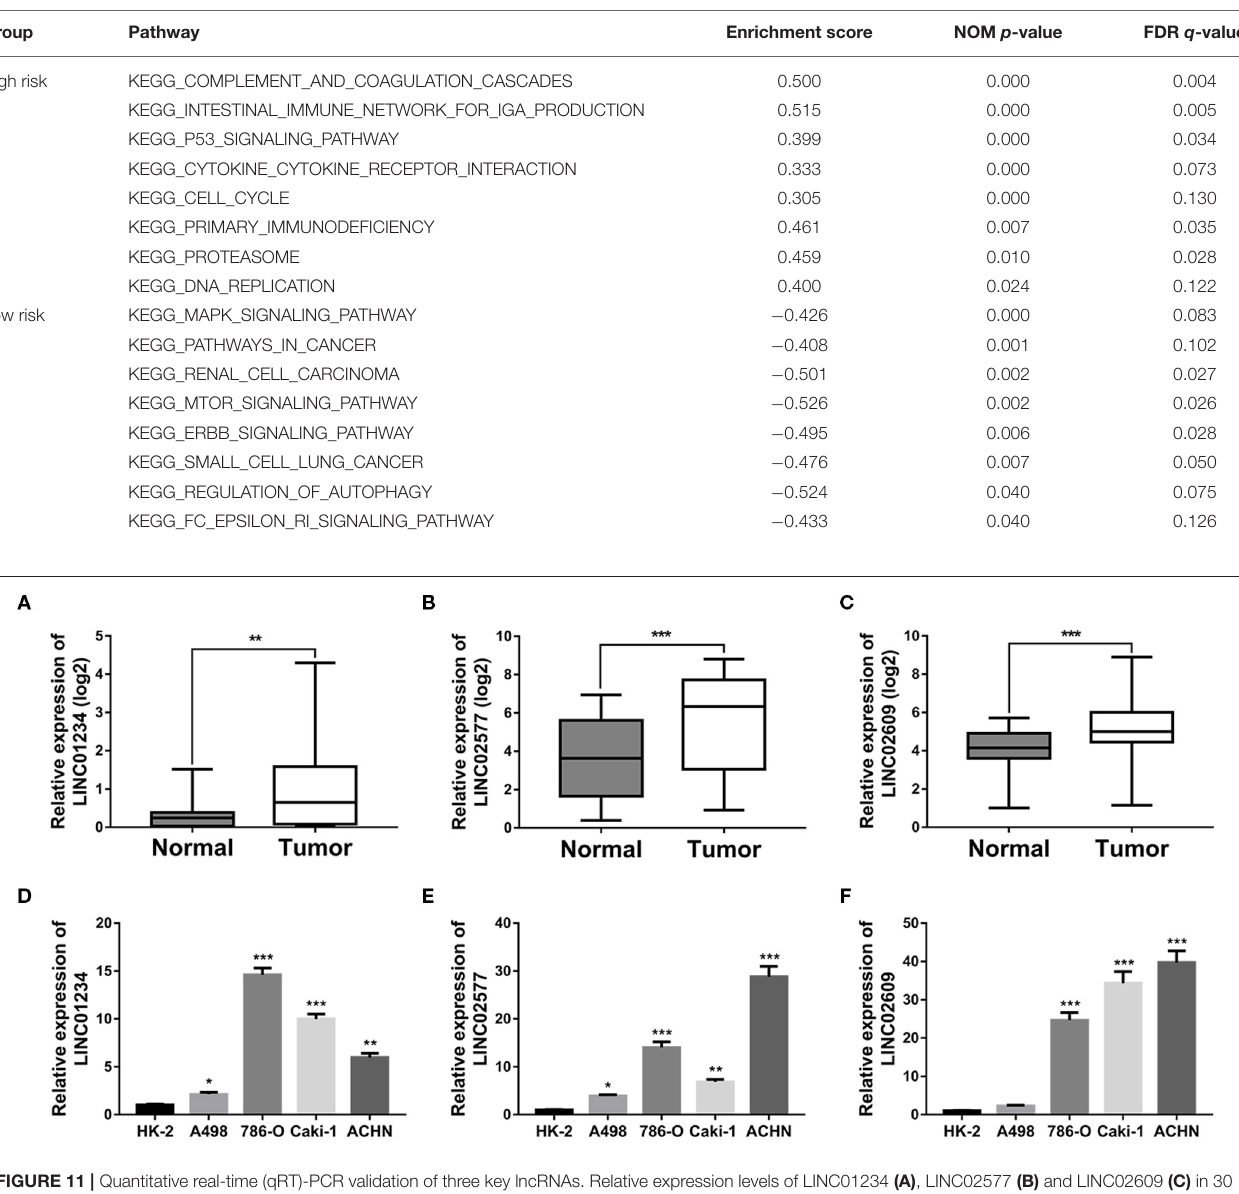
prognosis and the pathological stages of patients with